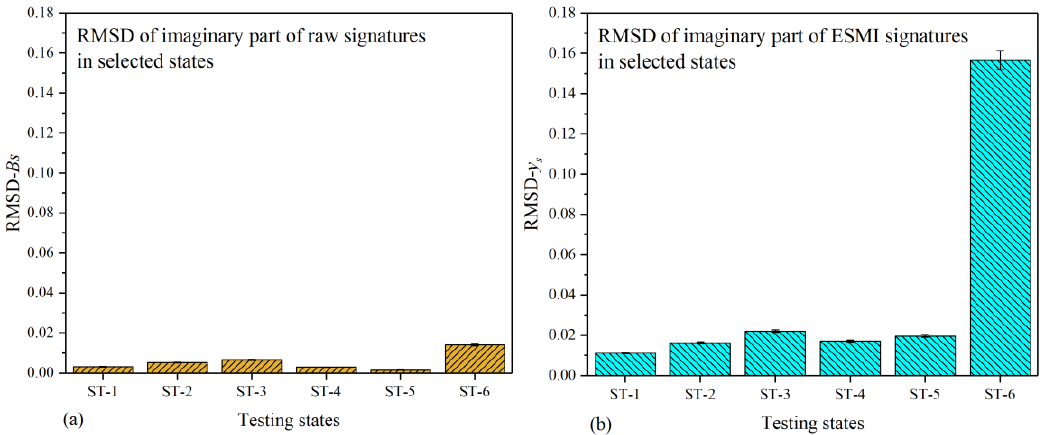
Figure 7. Histogram based on imaginary part of raw and ESMI signatures: ( a ) B s ; ( b ) y s .